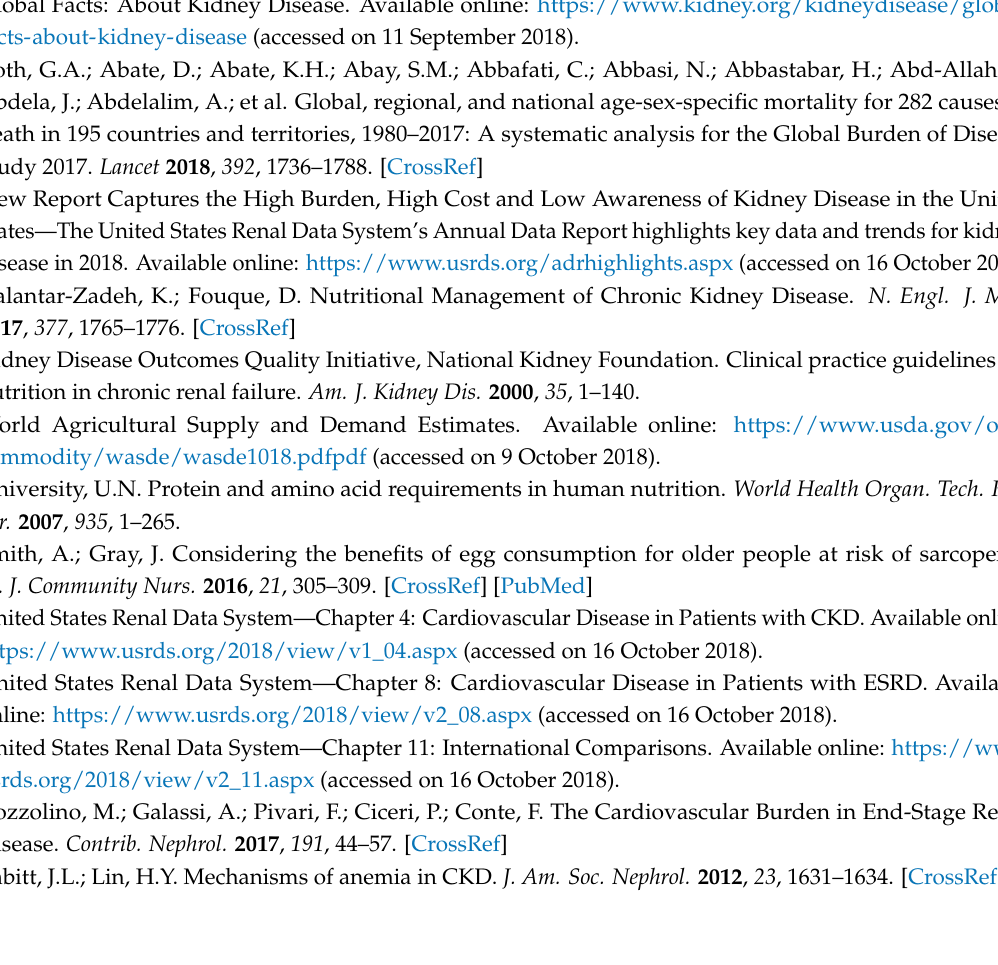
Table S1: Articles assessed for the current